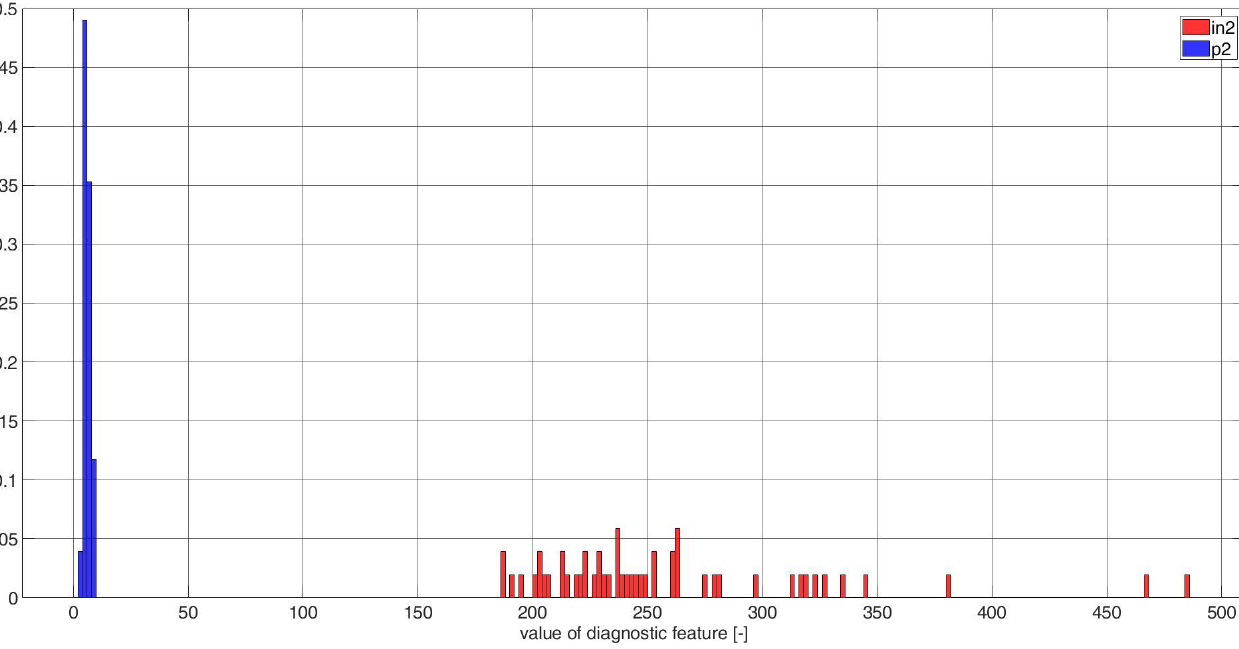
Figure A6. Histogram of diagnostic features based on the CCSM3 (correlation number is 6 — Table A1) bearings in2 and p2.